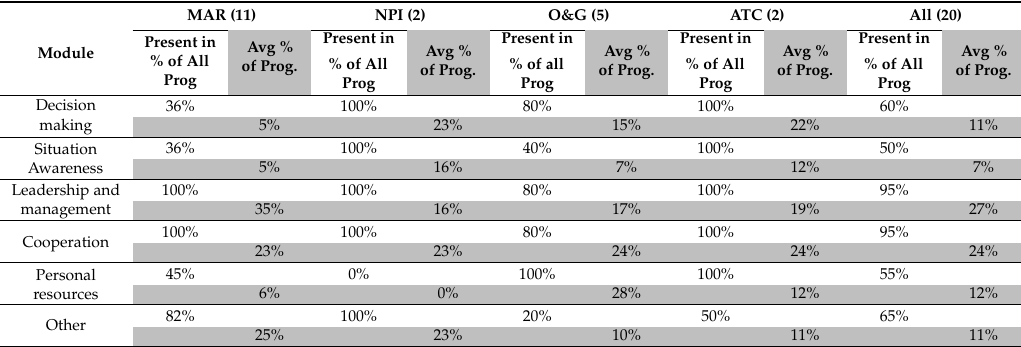
Table 6. Modules in CRM training by NOTECHS